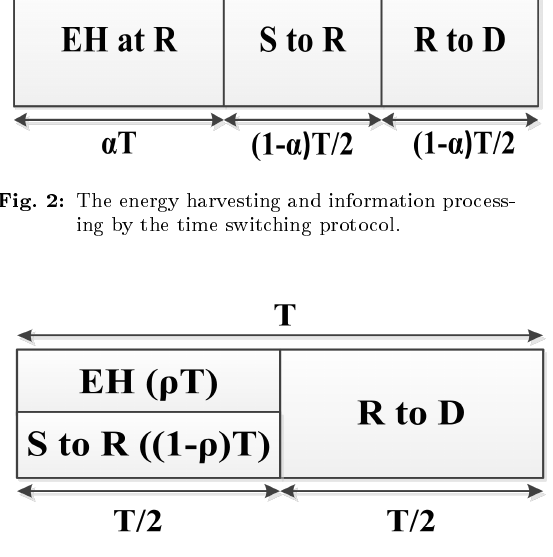
Fig. 3: The energy harvesting and information process- ing by the power splitting